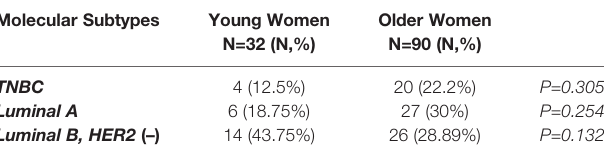
TABLE 2 | Intrinsic subtypes of breast cancer in younger (<40 years) and older (>40 years) women with breast